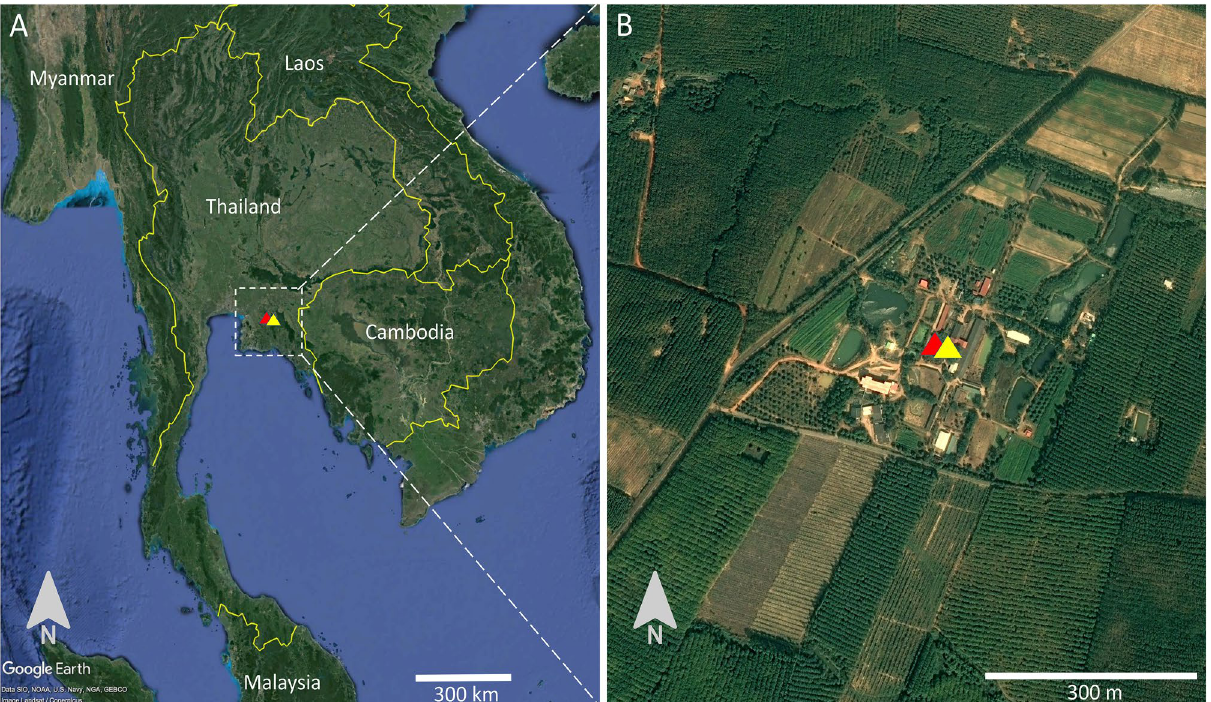
Figure 2. Phylogenetic positions of Plasmodium detected from Anopheles mosquitoes in this study. The phylogenetic tree was inferred by Bayesian inference method using partial cytb sequences (789 bp). Haemoproteus columbae was used to root all sequences. At the nodes, Bayesian posterior probabilities (PP ≥ 0.65) are indicated. Plasmodium sequences obtained in this study are highlighted in red. The length for the substitutions/site (0.02) is